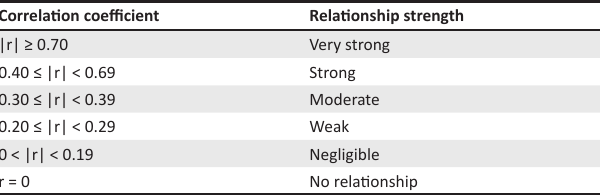
TABLE 2: Correlation coefficient strength interpretation. Correlation coefficient Relationship